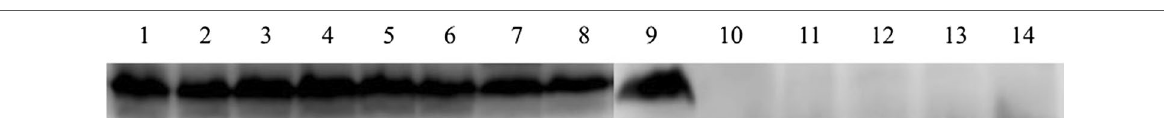
Fig. 4 Western blot analysis of specificity of the MAb 3E2. Before test, all the bacteria sample was adjust to the same concentration. Using MAbs 3E2 (1:1000) as primary antibody, and HRP-conjugated goat anti-mouse IgG (1:5000) as secondary antibody. Lane 1–12 were cell lysate of SE50336, 994, T48, W32, Stm1, W36, W37, U81, U82, SG9R, CVCC526, CE2, CE7 and DH5α, respectively. Western blotting results demonstrated that the MAbs 3E2 reacted specifically to the flagellated Salmonella strains (lane 1–9). However, no reaction with the non-flagellate Salmonella strains (lane 10,